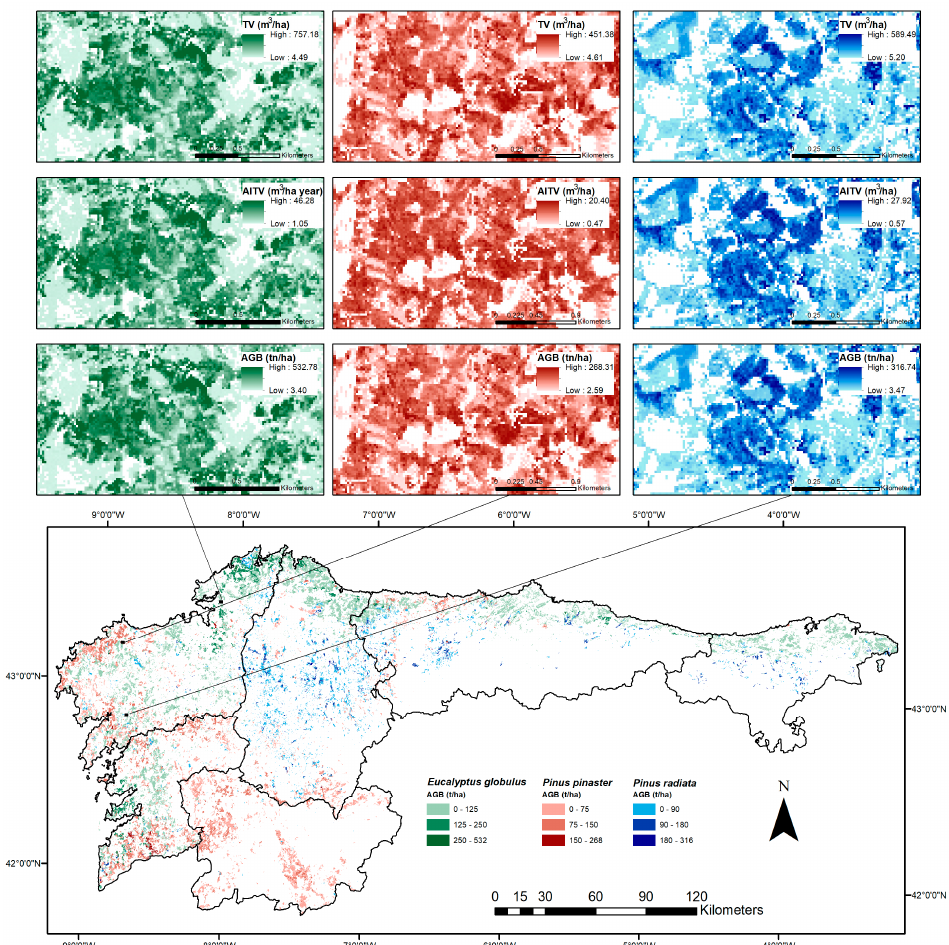
Figure 5. Spatial distribution of the total aboveground biomass (t / ha) in north-western Spain (bottom). Top: Map details (25-m spatial resolution) for TV (m 3 / ha), AITV (m 3 / ha year) and AGB (t / ha) in E. globulus (row 1), P. pinaster (row 2) and P. radiata (row 3).